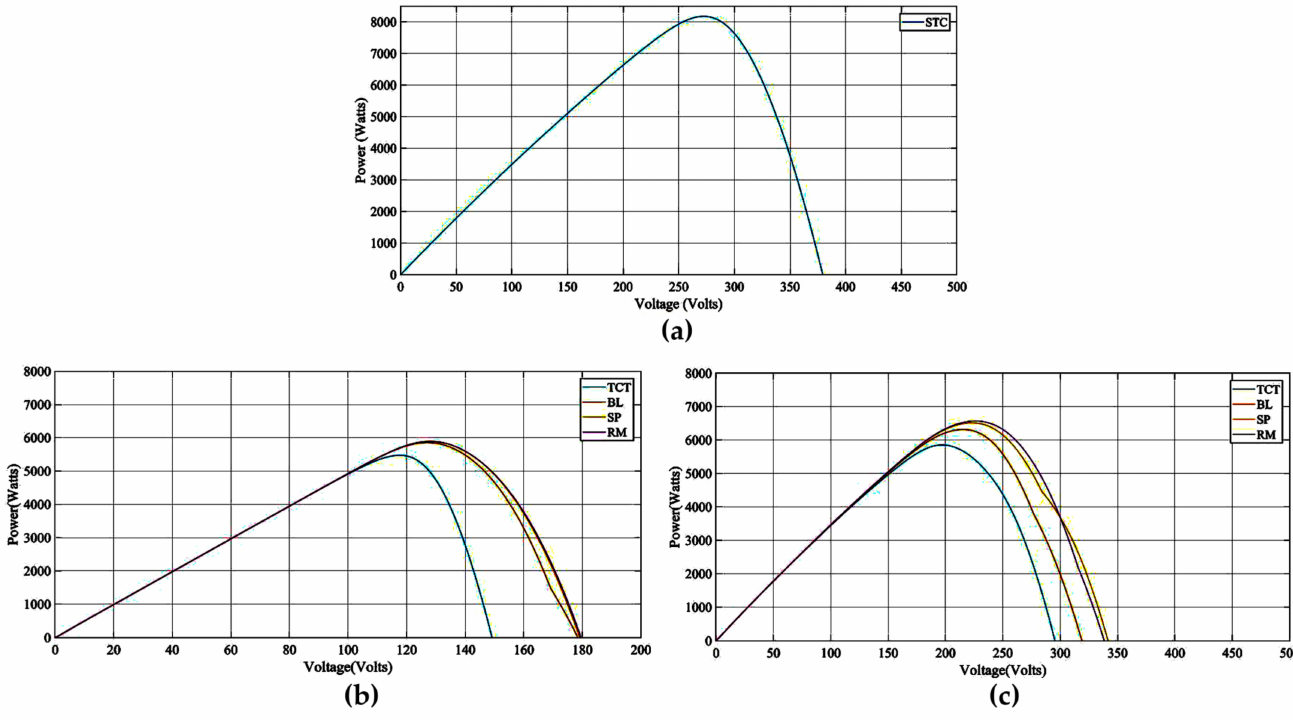
Figure 7. P-V curves under different architectures and operating conditions: ( a ) P-V curves under normal operating condition; ( b ) P-V curves under bridge fault (polycrystalline); ( c ) P-V curves under bridge fault (copper indium gallium selenide). Reproduced from [45], IEEE: